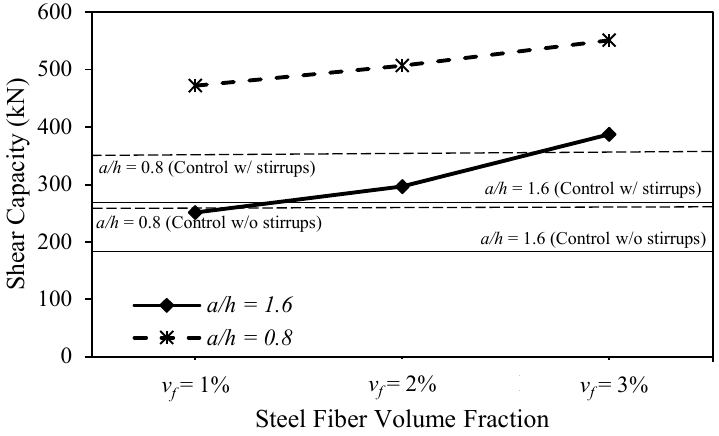
Figure 19. Effect of a/h on the shear capacity of RCA-based models.